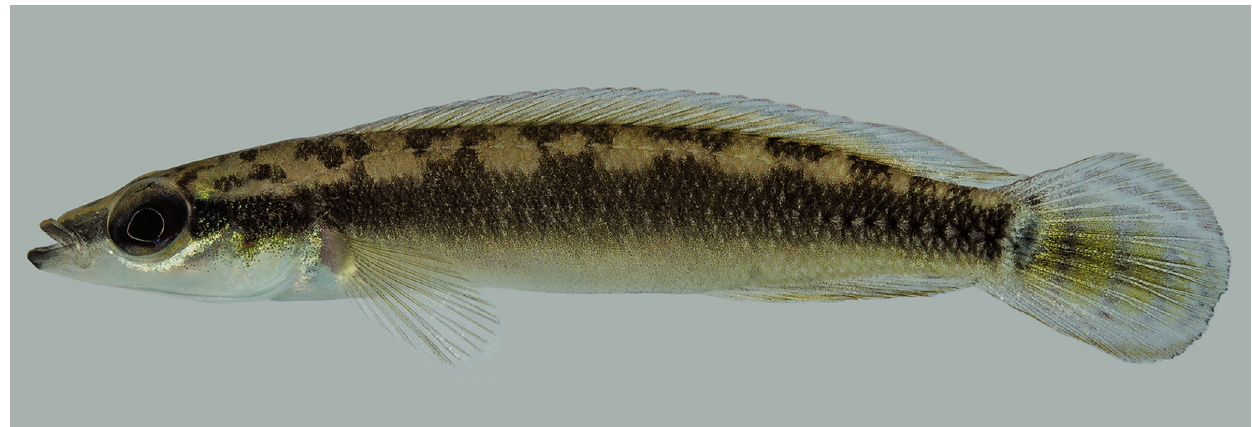
Fig. 2. Crenicichla anamiri , live specimen, paratype, INPA 46651, 43.3 mm SL, Brazil, State of Pará, Itapuama, rio Xingu. Photo by Leandro